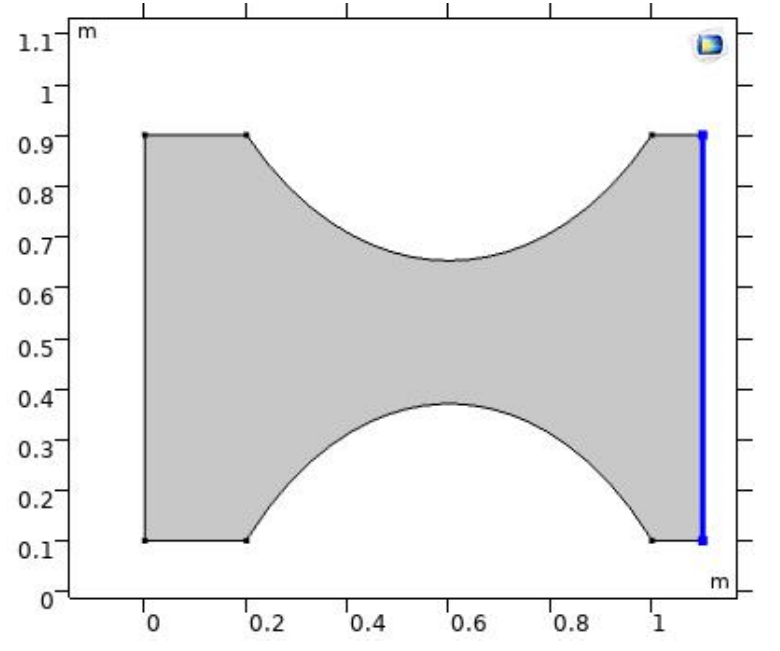
Figure 3. The geometry of the outlet.